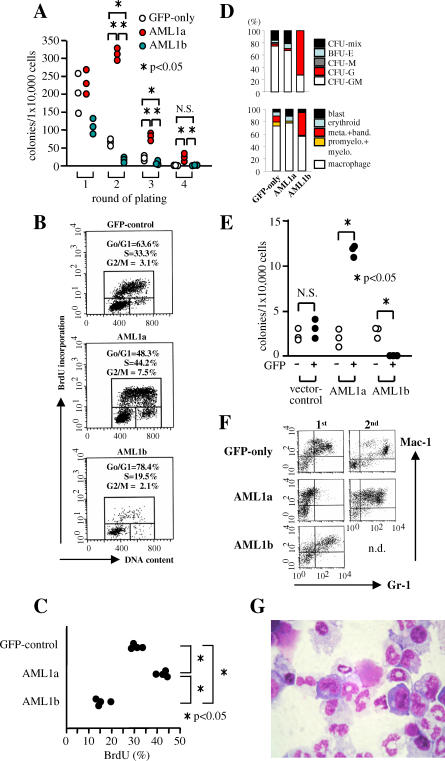
Myeloid Potential of AML1a- or AML1b-Transduced Cells(A) Frequency of CFCs in serial replating experiments; we sorted 1 × 104 GFP+ cells immediately after infection with GFP vector-only, AML1a-containing, or AML1b-containing viruses, and they were plated. For replating, cultures were harvested on day 7 and 1 × 104 cells replated. Representative data from no fewer than three independent experiments conducted in triplicate are presented. Kruskal-Wallis test showed statistical significance of difference (p < 0.05) of colony numbers generated by the three populations (GFP, AML1a, and AML1b) in rounds 2, 3, and 4, but not in round 1. Difference of any given two populations was therefore analysed in rounds 2, 3, and 4, by Mann-Whitney test, with asterisks indicating statistical significance of the difference.(B) Representative cell-cycle analyses of control and AML1a- or AML1b-transduced cells from the second round of replating are presented. Cells harvested from CFC assays were pulsed with BrdU and analysed for BrdU incorporation along with DNA content.(C) Graphical summary of cell-cycle data from four independent experiments. Kruskal-Wallis test showed statistical significance of difference (p < 0.01) of the three populations (GFP, AMl1a, and AML1b) and Mann-Whitney tests showed statistical significance of the difference between any given two populations (p < 0.05).(D) Colony types formed in multimyeloid conditions (upper bar graph) are shown. After typing on day 7, cultures were harvested for cytospin preparations and differential counting (lower bar graph).(E) CFU-meg formation was analysed. BM cells from 5-FU-treated BALB/c mice were infected with viruses for vector-alone, AML1a, and AML1b, and then sorted into GFP+ and GFP− cells for colony assays (triplicate). Two experiments yielded a similar result. Asterisks indicate statistical significance of the difference estimated by Mann-Whitney test.(F) FACS analysis for myeloid-differentiation markers (Gr-1 and Mac-1) on cells harvested from colonies at the first and second replating.(G) Photomicrograph of AML1a-transduced cells harvested from second replating.